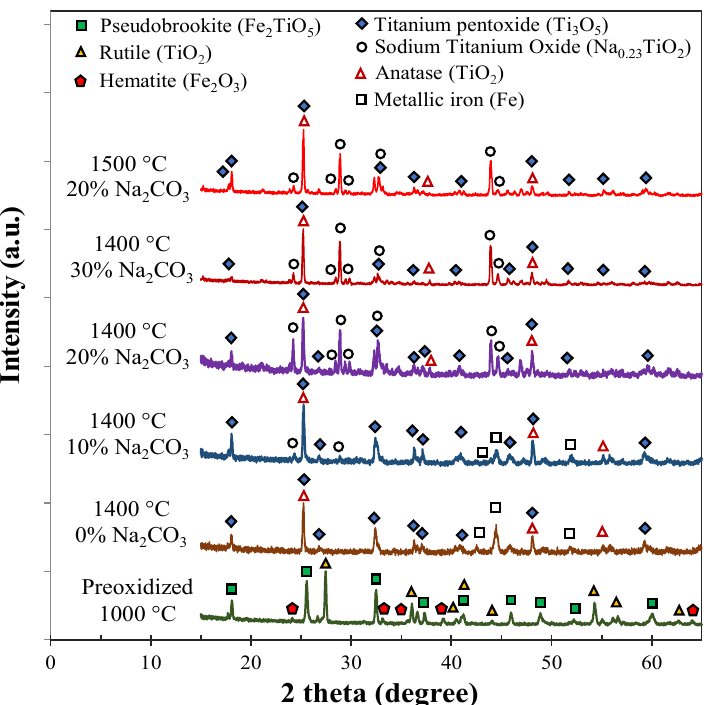
Figure 5. XRD spectra of the reduced briquettes for a final temperature of 1400 ◦ C (pattern B) with 0% and 10% Na 2 CO 3 additions, the slags after metal granules separation for a final temperature of 1400 ◦ C (pattern B) with 20% and 30% Na 2 CO 3 additions, and the slag after metal granules separation for a final temperature of 1500 C (pattern C) with 20% Na 2 CO 3 addition.